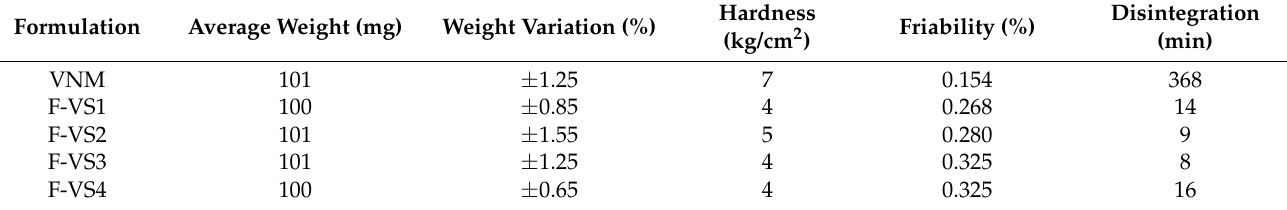
Table 5. Post compression parameters for VNM and F-VS. Table 6. Formulation of